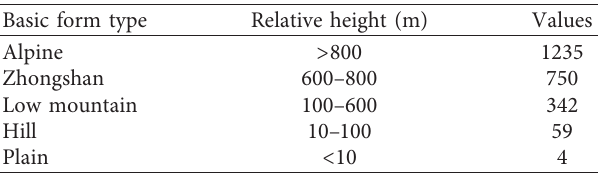
Table 1: Scale hierarchy in multiscale studies related to landscape